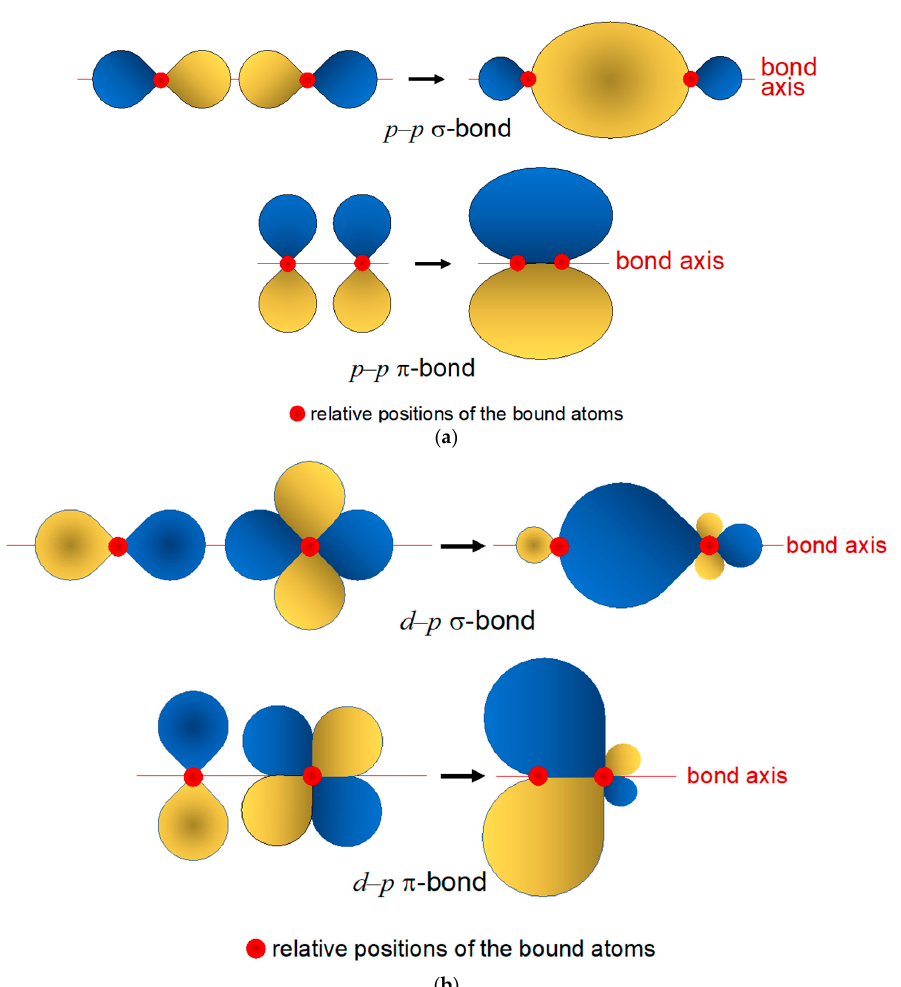
Figure 2. Examples of formation of σ and bonding orbitals from the overlap of ( a ) p–p and ( b ) d–p orbitals.